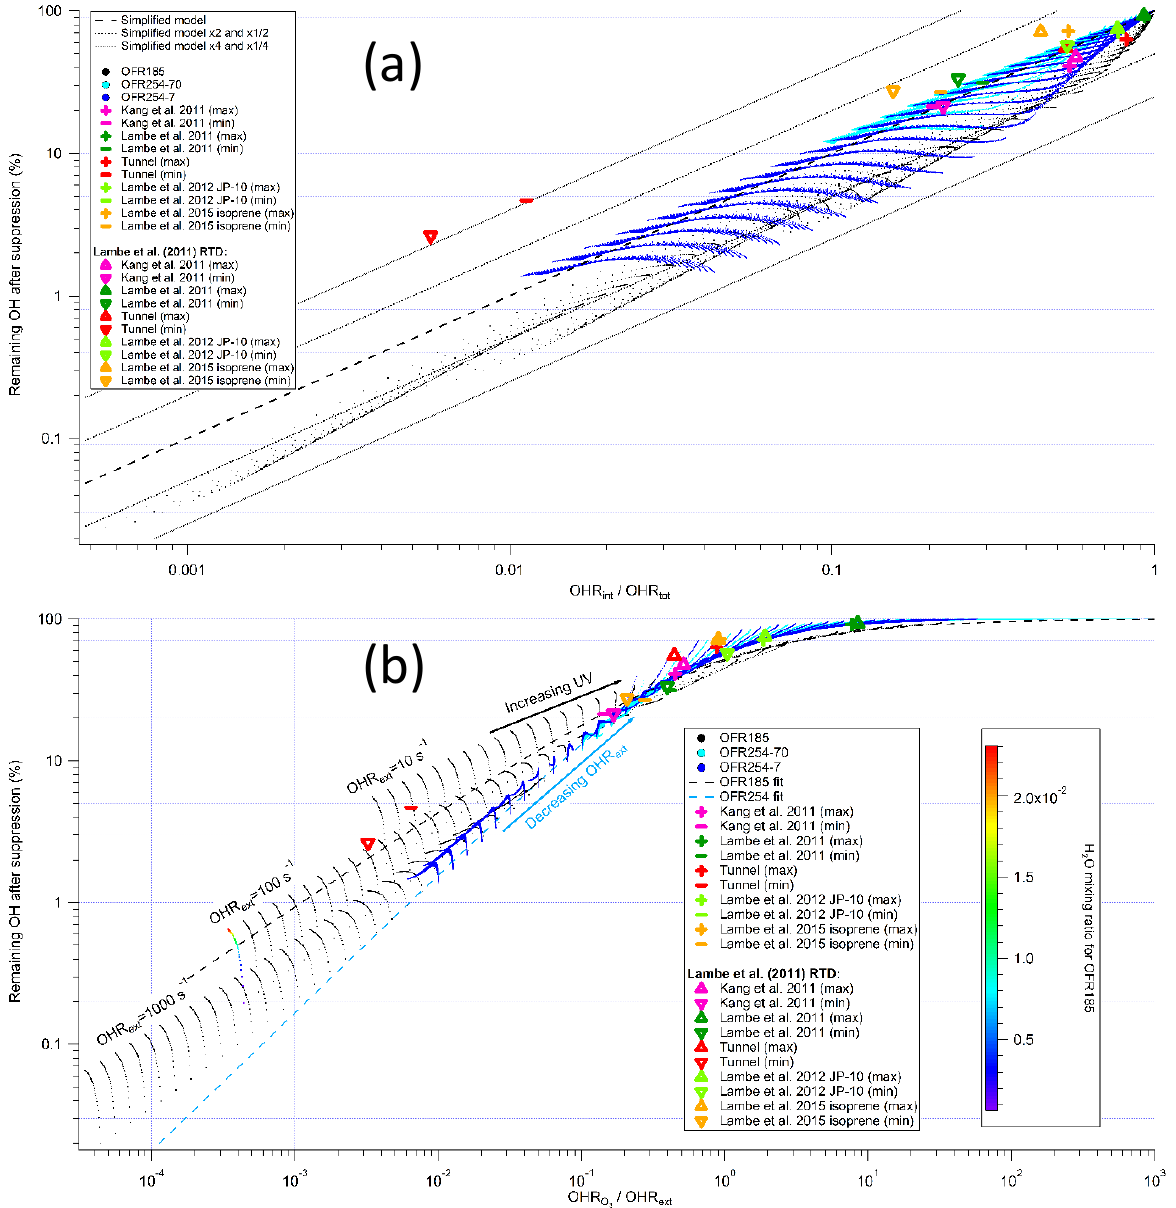
Figure 11. (a) Percentage of remaining OH after suppression in OFR185 (black dot), OFR254-70 (cyan dots), and OFR254-7 (blue dots) vs. the ratio between internal and total OH reactivities. The “simplified model” (Eq. 8) prediction as well as lines at x2, x4, x1/2, and x1/4 of the simplified model are also shown for comparison. The estimated ranges for laboratory experiments (Kang et al., 2011; Lambe et al., 2011b, 2012, 2015) and a source study in an urban tunnel Tkacik et al., 2014) are also shown. These ranges are estimated by the models with plug flow and with the Lambe et al. (2011a) residence time distribution according to the experimental conditions in these studies. The lower limit of the percentage of remaining OH after suppression in the tunnel study is notably above the simplified model, since the large amount of NO x in that case destroys a significant fraction of the internal OH reactants (e.g., O 3 , HO 2 , and OH), leading to OHR int , 0 / OHR int much higher than 1, while the major contribution of H 2 O photolysis to both P and P 0 leads to P/P 0 close to 1. (b) Percentage of remaining OH after suppression in OFR185 (black dot), OFR254-70 (cyan dots), and OFR254-7 (blue dots) vs. the ratio of OH reactivity from O 3 to external OH reactivity. The fit curves for OFR185 (black dash) and OFR254 (light blue dash) are shown. The estimated ranges for laboratory experiments (Kang et al., 2011; Lambe et al., 2011b, 2012, 2015) and a source study in an urban tunnel (Tkacik et al., 2014) are also shown. These ranges are estimated by the models with plug flow and with the Lambe et al. (2011a) residence time distribution according to the experimental conditions in these studies (see text). The three series of OFR185 datapoints corresponding to OHR ext = 10, 100, and 1000s − 1 are respectively labeled. A strip of OFR185 datapoints are colored by H 2 O mixing